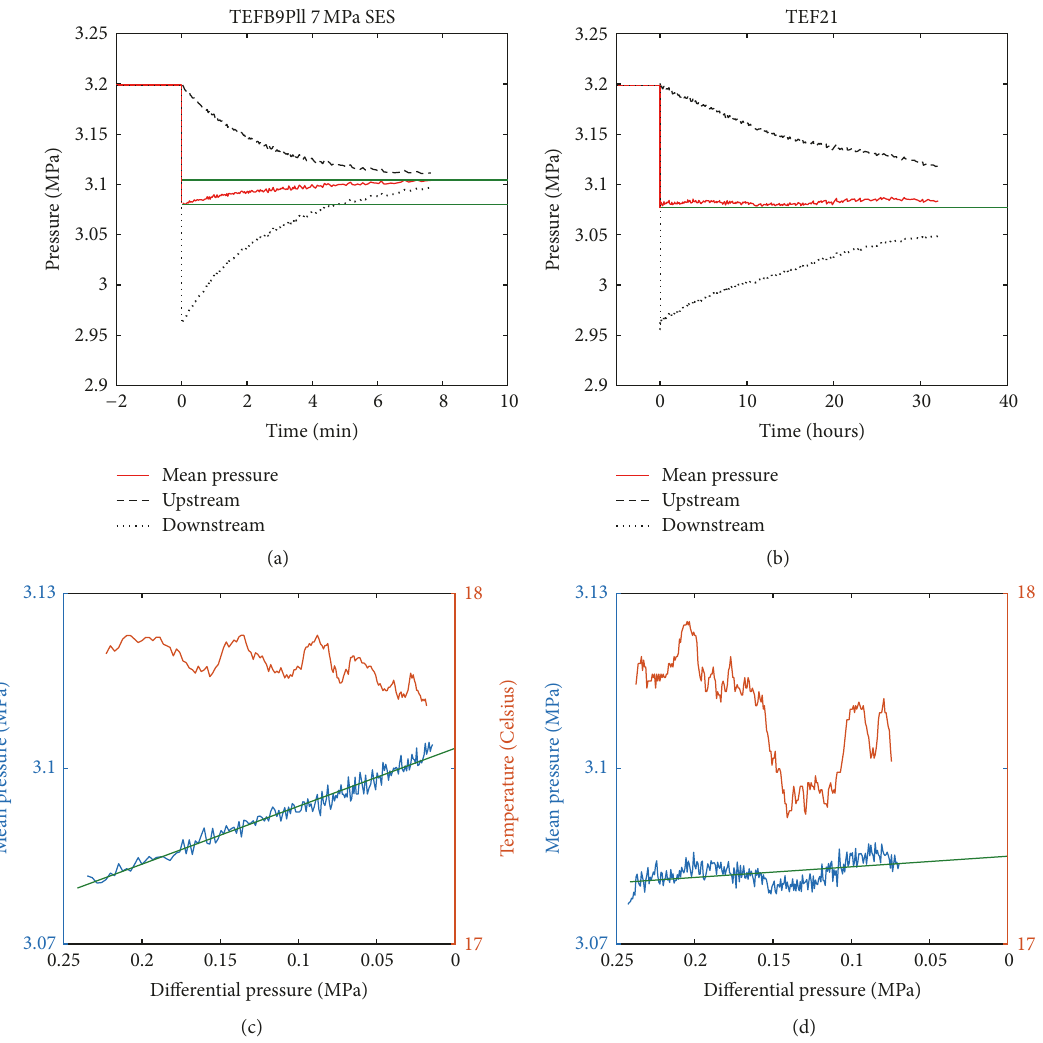
Figure 9: Examples of good quality ethane pulse decay pressure data for a high permeability sample from which accurate desorption rates could be calculated ((a) and (c)) and poor quality data for a low permeability sample from which accurate desorption rates could not be calculated ((b) and (d)). Temperature fluctuation over the duration of the measurement has a significant impact on mean pore pressure for the low permeability sample (d). Data collection for the low permeability sample was stopped at ∼ 0.07 MPa differential pressure because of the excessive time required for full decay (b). Green lines in (a) and (b) indicate the difference between minimum mean pressure and final equilibrium